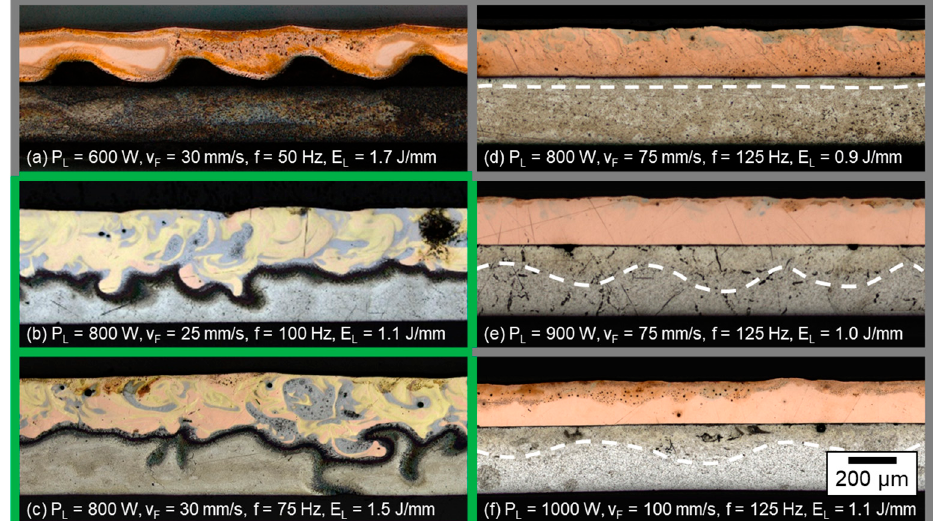
Figure 9. Longitudinal sections of welds produced with vertical eight circular beam oscillation for different laser powers and feed parameters (v F, f); welding direction from left to right.